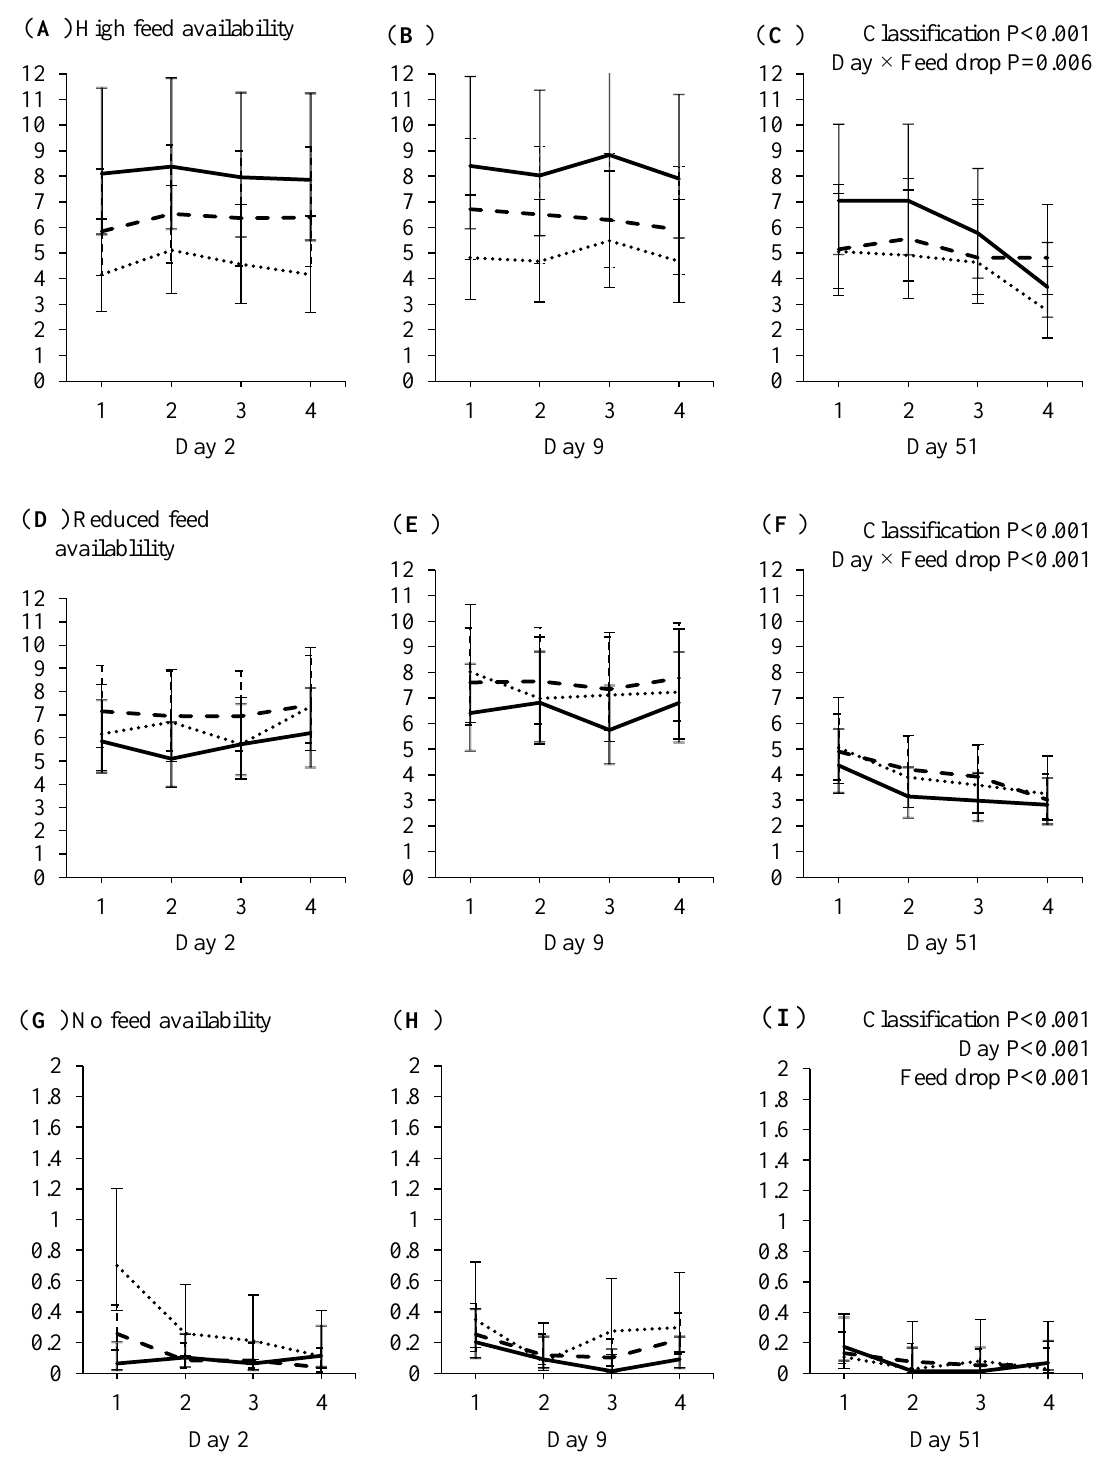
Figure 2. Gestation 1: The average (±95% confidence interval) number of times dominant ( ▬ ), subdominant (—) and submissive ( ··· ) sows were recorded showing feeding behavior (y-axis) in areas associated with high ( A – C ), reduced ( D – F ) or no ( G – I ) food availability, when fed over four feed drops (x-axis) on days 2, 9 and 51 post-mixing.